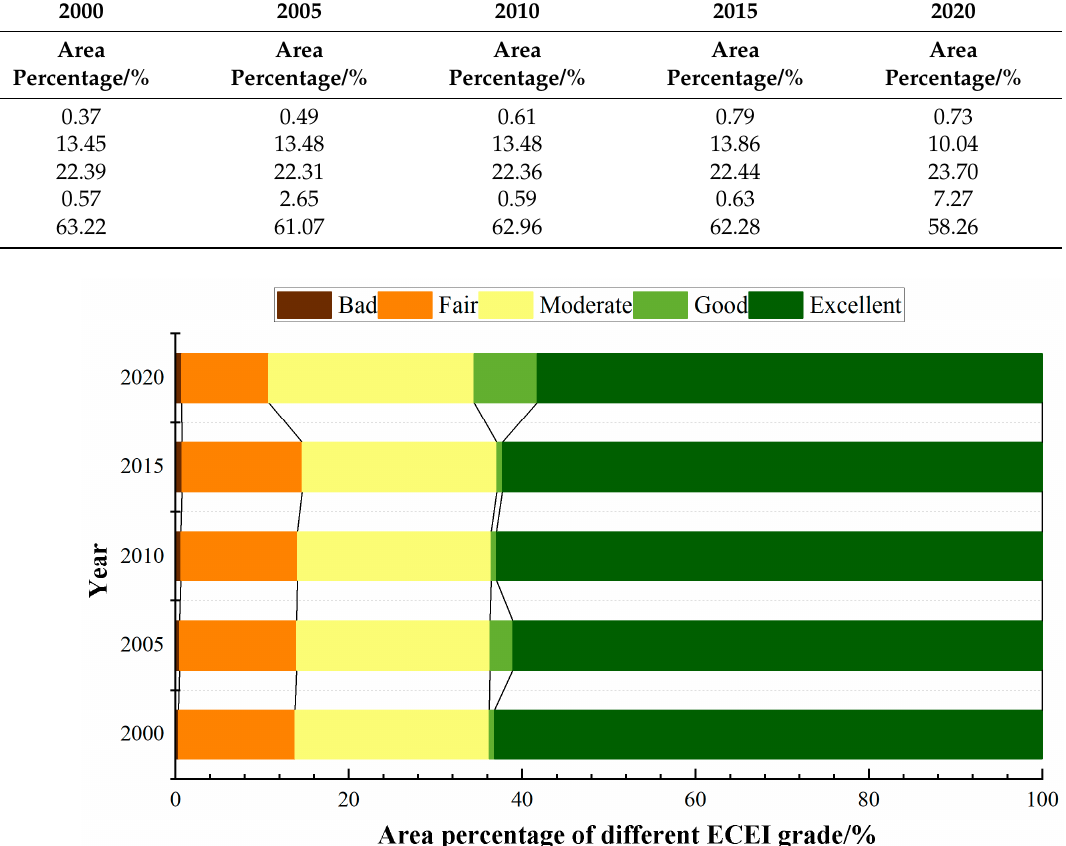
Table 4. Area percentage of different ECEI grades.